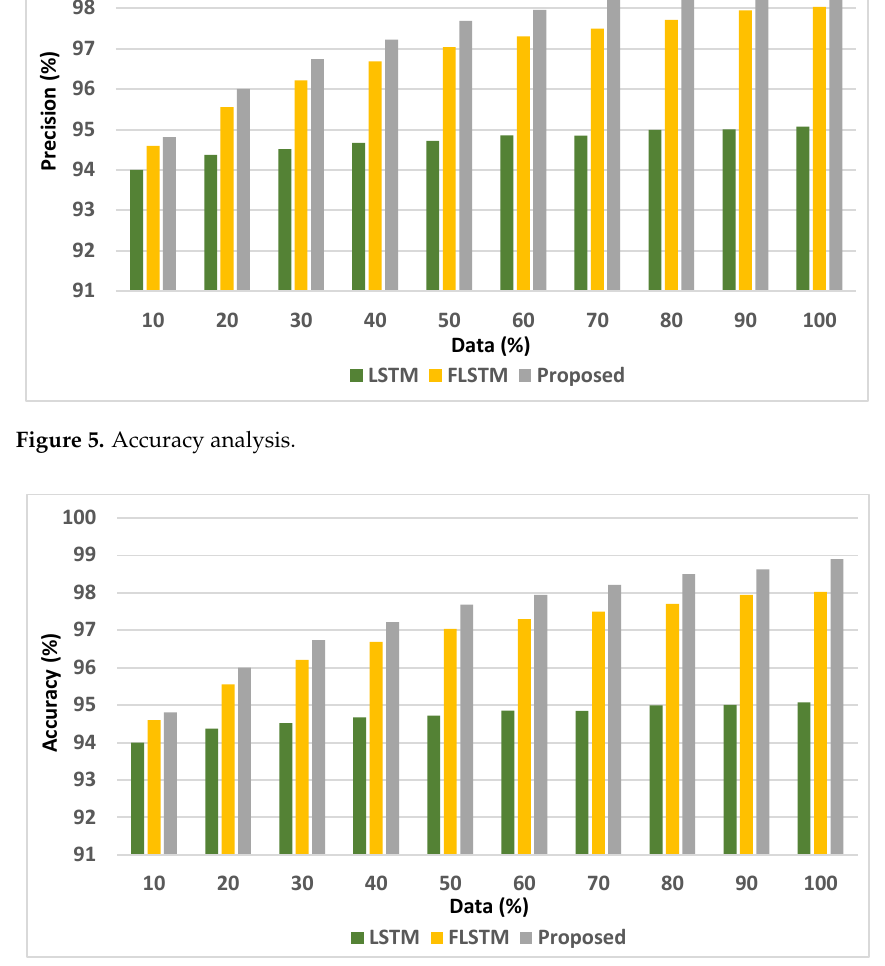
Figure 6. Precision analysis.